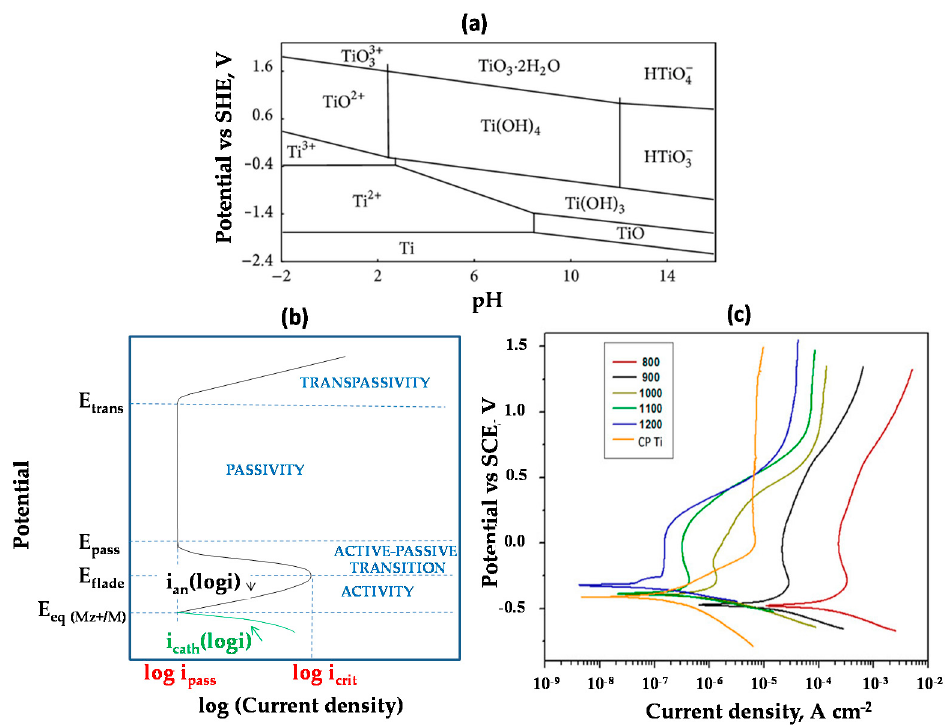
Figure 5. ( a ) Potential pH diagram for the Ti–H 2 O system at 25 ◦ C. Reproduced under the Creative Commons Attribution License from [51]. ( b ) Theoretical passivation potentiodynamic polarization curves relating to a general metal or alloy with a typical active–passive behavior in a corroding environment. E pass = passivity potential, E flade = Flade potential, E corr = corrosion potential, E trans = transpassivity potential, i pass = passivity current density, i crit = critic current density. ( c ) Experimental passivation potentiodynamic polarization curves relating to a Ti-20Nb-13Zr alloy processed at different consolidation temperatures in a simulated body fluid medium. Reproduced under the Creative Commons Attribution License from